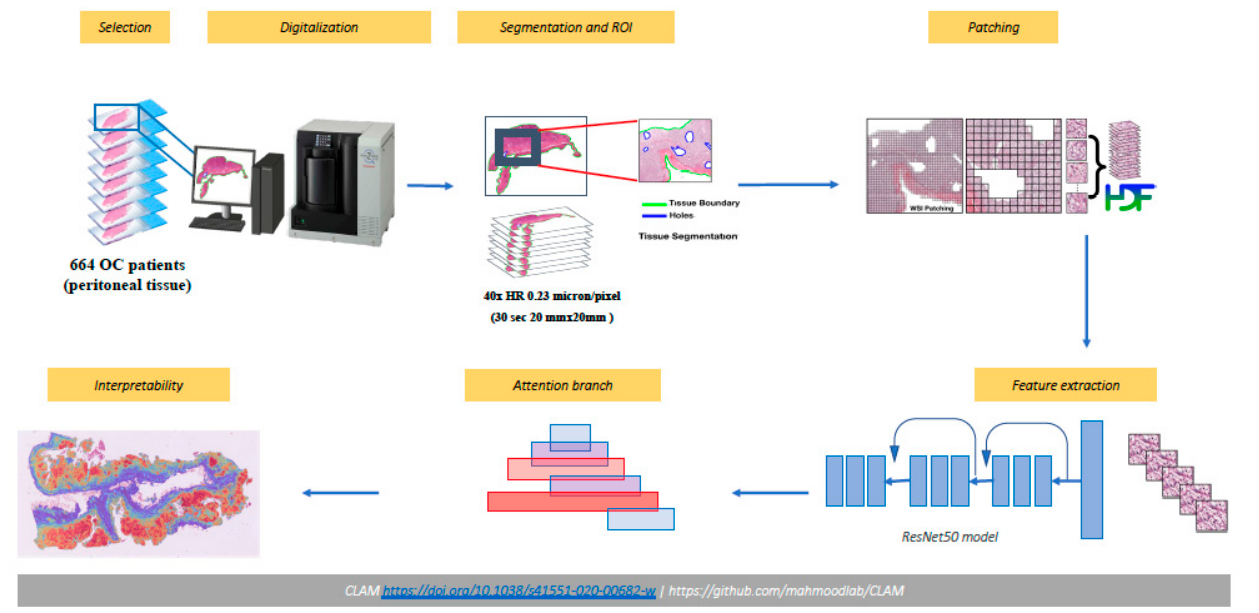
Figure 2. Pipeline of analysis.